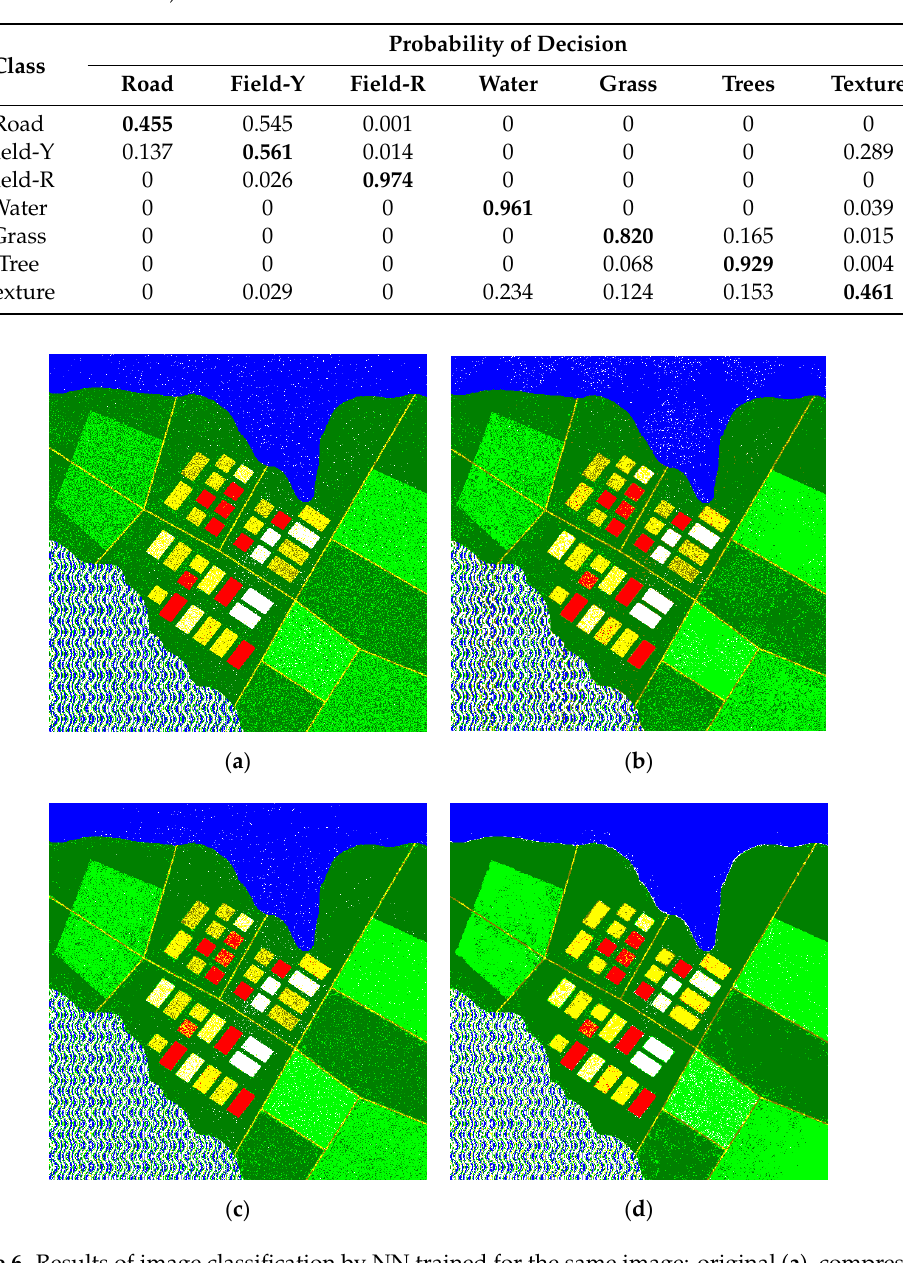
Figure 6. Results of image classification by NN trained for the same image: original ( a ), compressed with PSNR-HVS-M = 42 dB ( b ), compressed with PSNR-HVS-M = 36 dB ( c ), compressed with PSNR-HVS-M = 30 dB ( d